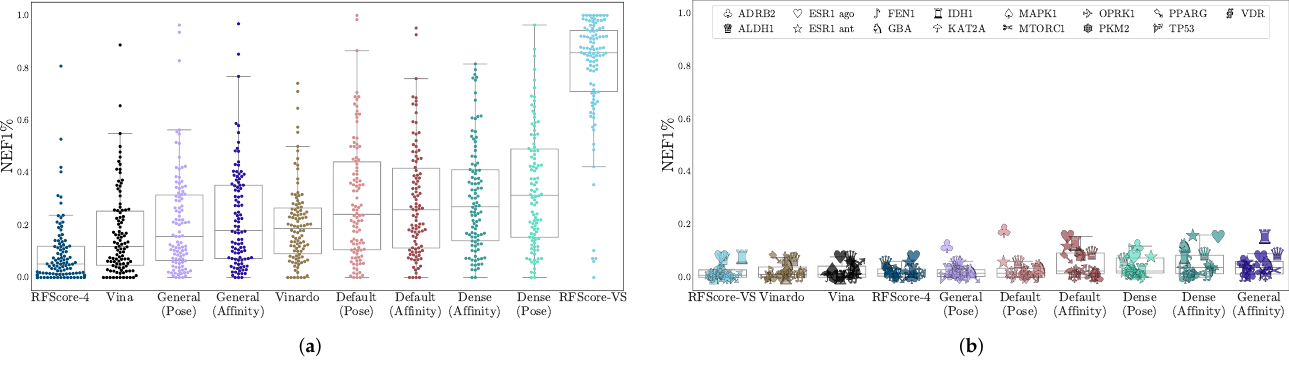
Figure 3. Assessment of virtual screening performance on ( a ) DUD-E and ( b ) LIT-PCBA using the NEF1% metric. The x -axis is sorted in order of increasing median performance. Each data point is the normalized 1% enrichment factor (NEF1%) of the method on a single target. LIT-PCBA targets are shown with distinctive individual markers. EF1% results are shown in Figure